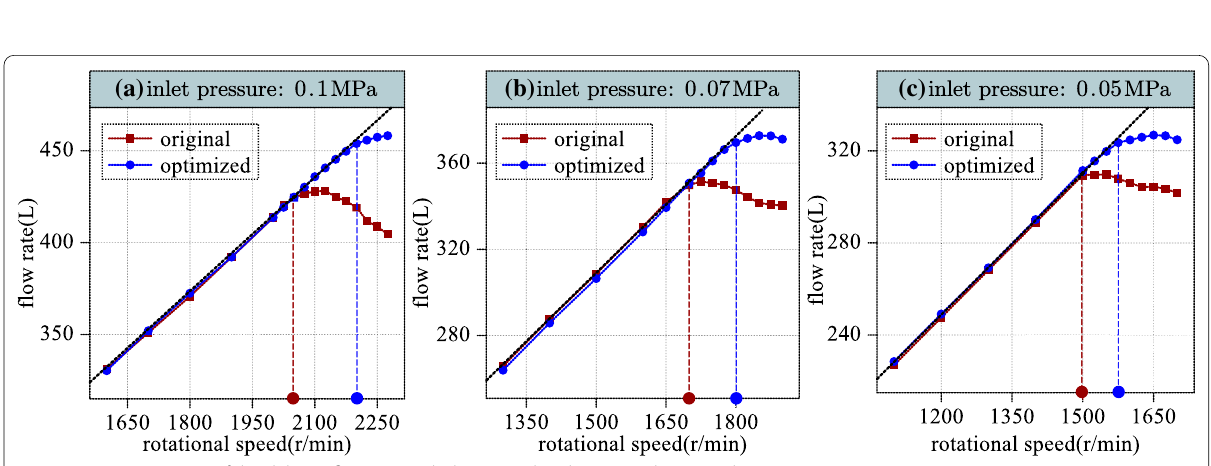
Figure 13 Comparison of the delivery flow rate with the original and optimized suction